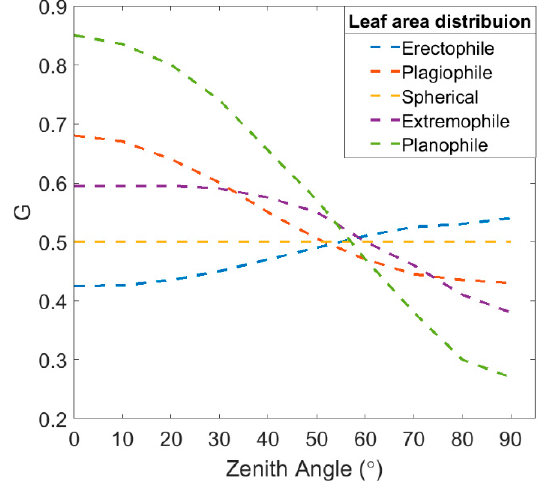
Figure 12. Archetype Leaf Angle Distributions.